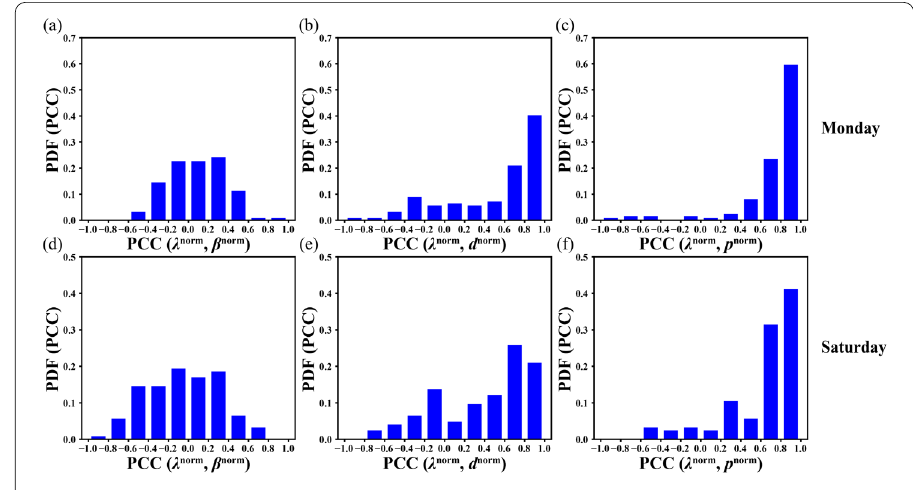
Figure 7 Distribution of PCCs between coupling strength and each index for all studied SDNs on Monday and Saturday. Coupling strength λ norm vs. ( a ), ( d ) speed ratio β norm ; ( b ), ( e ) average trip distance d norm ; ( c ), ( f ) the fraction of travelers from ordinary zones p norm